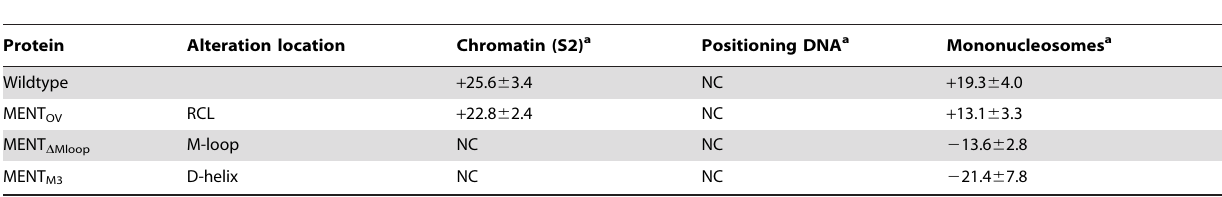
Table 1. Change in fluorescence intensity of MENT and mutant